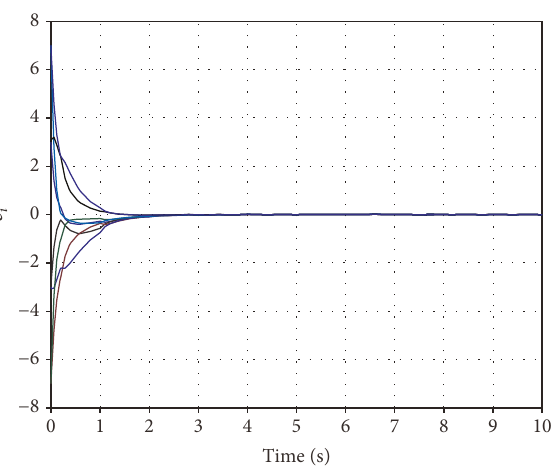
Figure 3: The synchronization errors of the resulting closed-loop